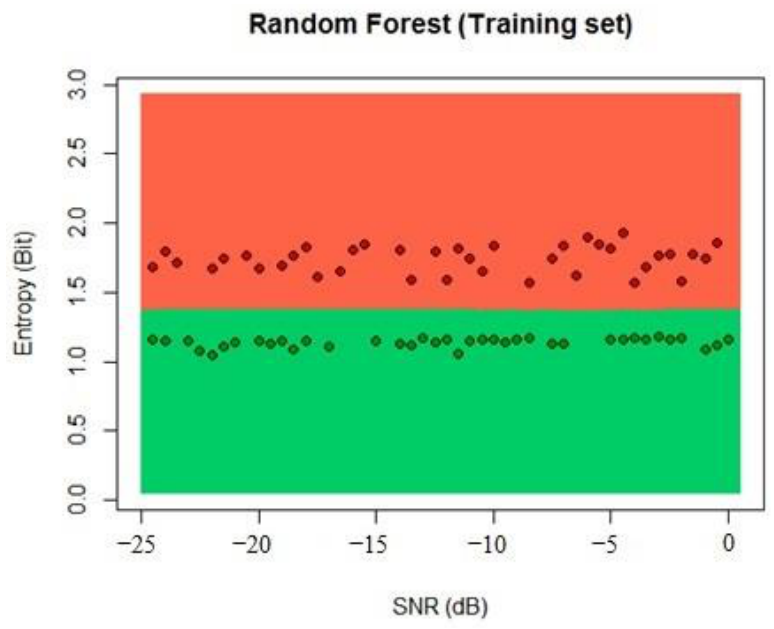
Figure 14. Random forest training process classification.